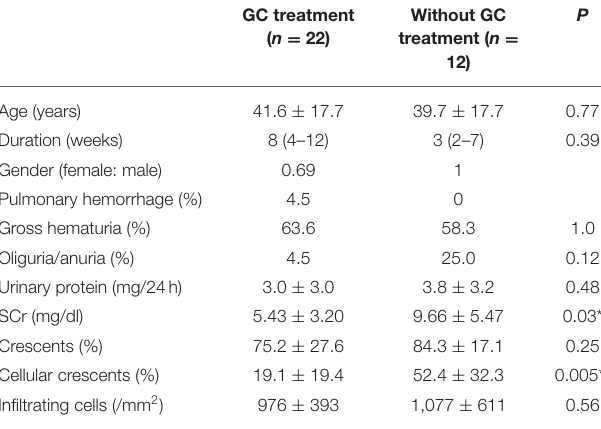
TABLE 1 | Characteristics of the patients with anti-GBM